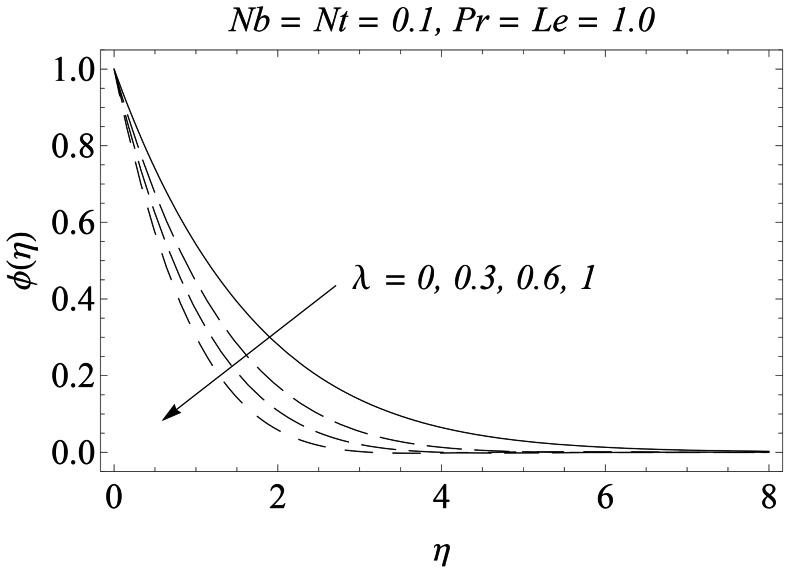
Influence of λ on .